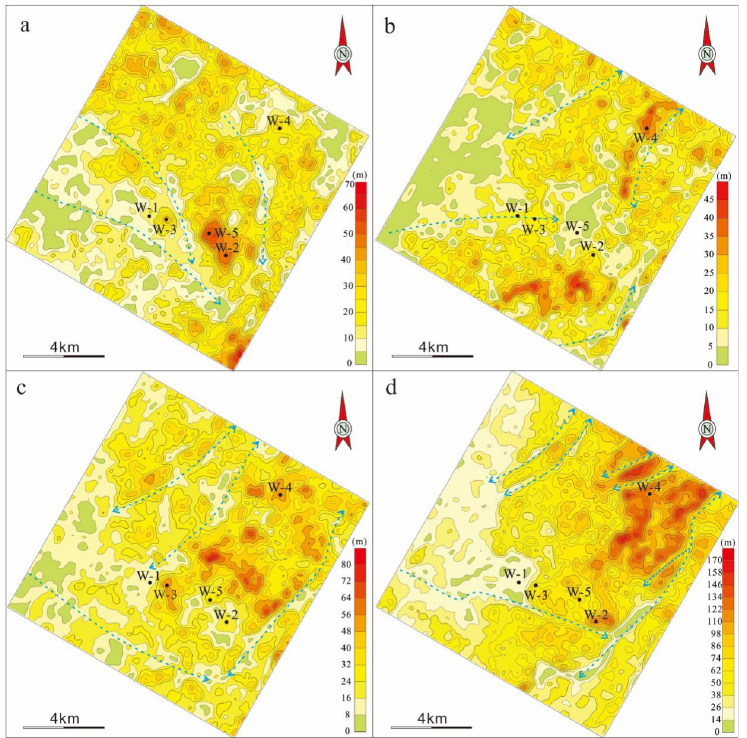
Figure 9. Lateral distribution of sand bodies within the LST stage of ( a ) SQ4, ( b ) SQ3, ( c ) SQ2, and ( d ) SQ1 based on the prestack seismic inversion technique. The blue dashed lines on the map indicate the possible